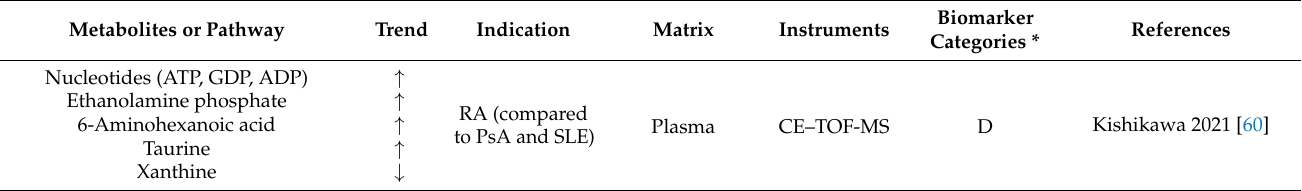
Table 4. Changes in metabolites and pathways that appear to be disease-specific for RA, PsA, or